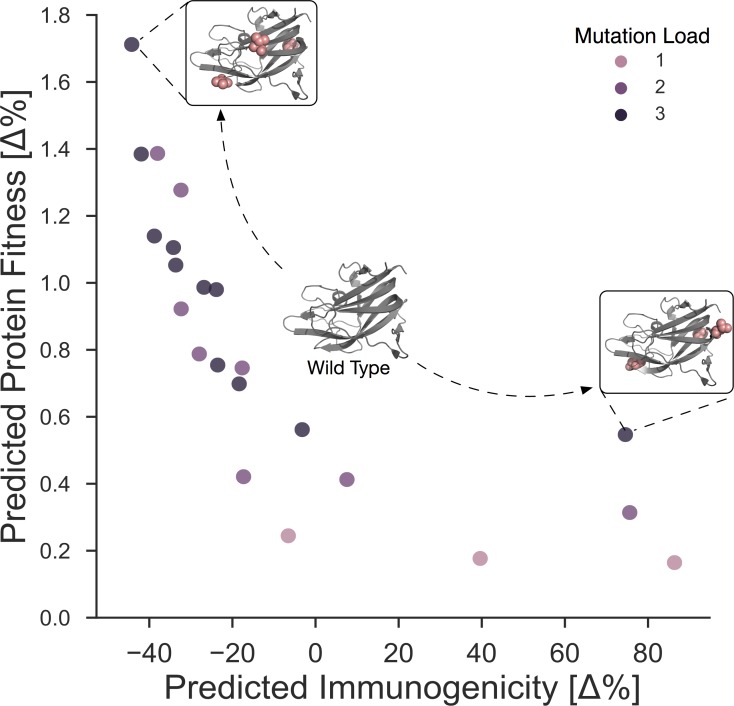
Pareto front of de-immunized designs in percent change compared to the wild type with k = 1,2,3 mutations. Each design is a tradeoff between the immunogenicity and the protein fitness function and represents a new sequence (here represented as tertiary structures). Immunogenicity is approximated by the HLA binding affinity predictions for a set of HLA molecules weighted by their HLA allele frequency in a specific population. The red spheres within the tertiary structures mark the mutated residues.